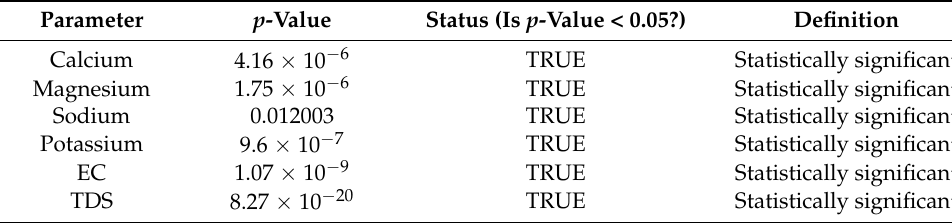
Table 2. Analysis of variance results.